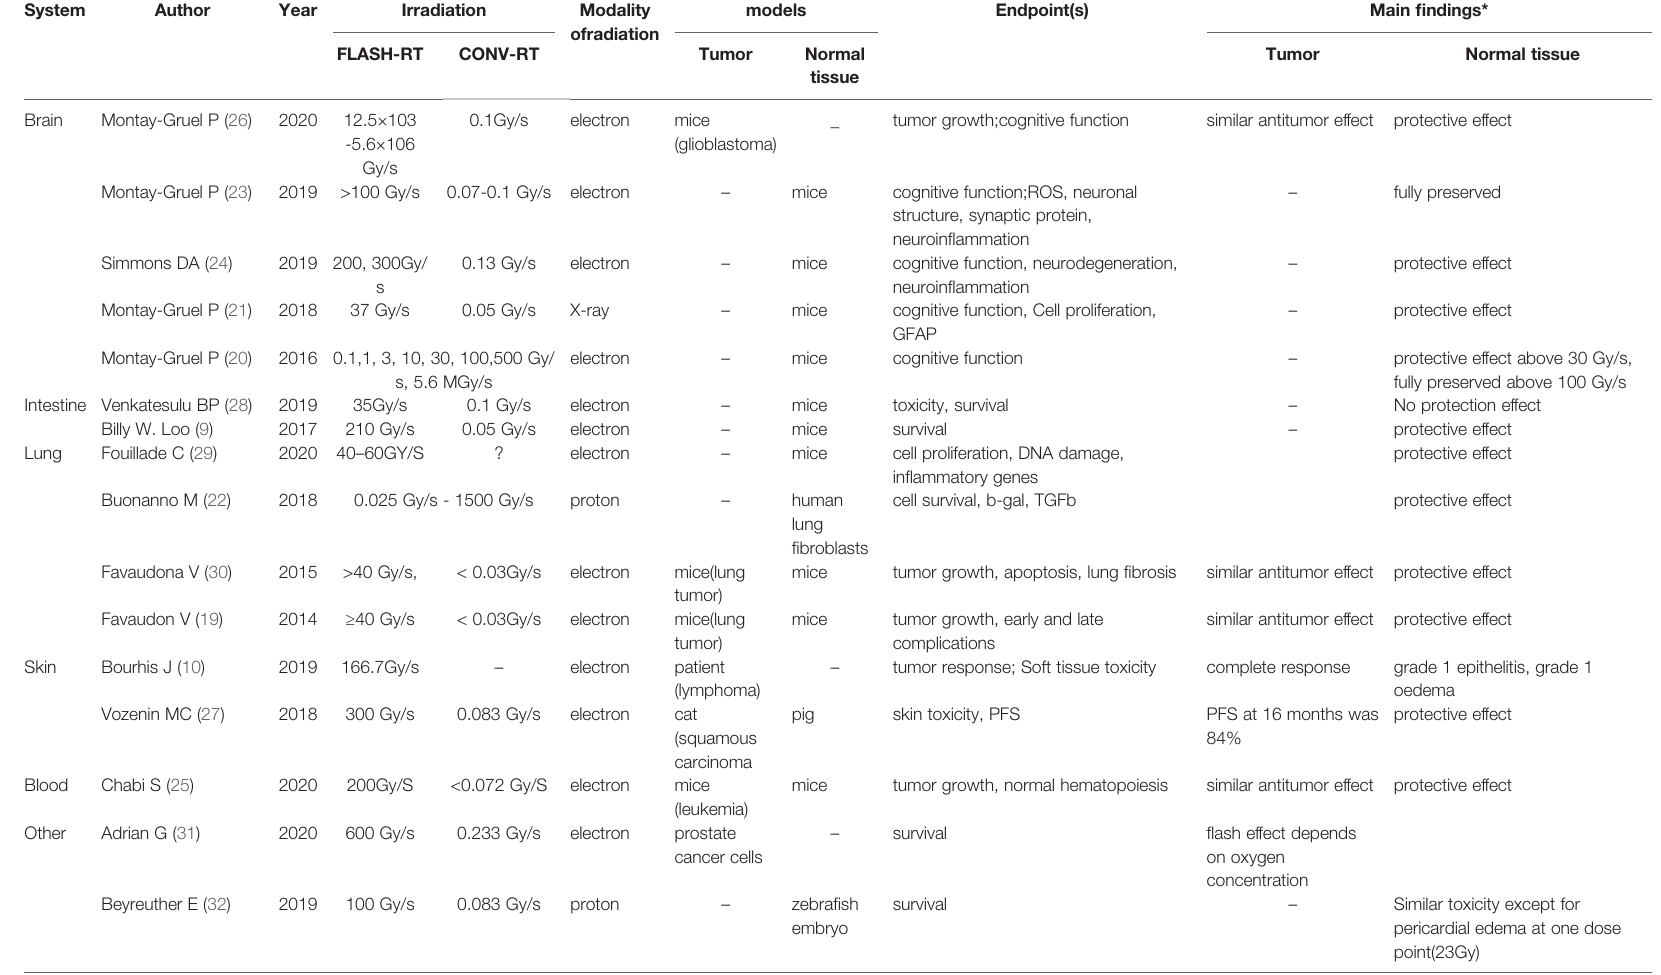
TABLE 1 | Summary of preclinical and clinical